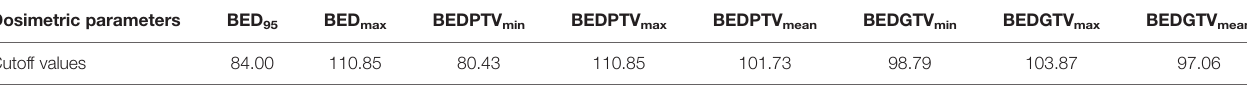
TABLE 1 | The optimal cut-off values of dosimetric